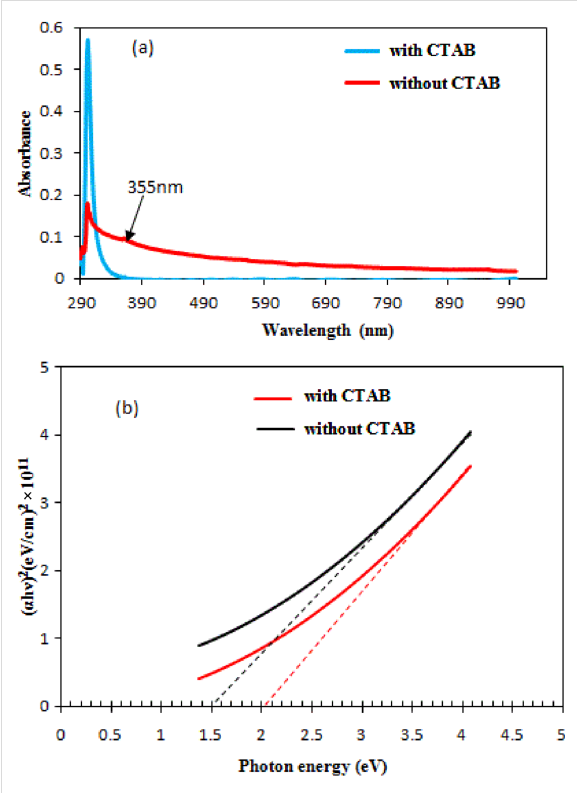
Figure 5: (a) Optical absorption of Ag 2 S prepared with and without CTAB, (b) ( α h ν ) 2 versus photon energy plot.